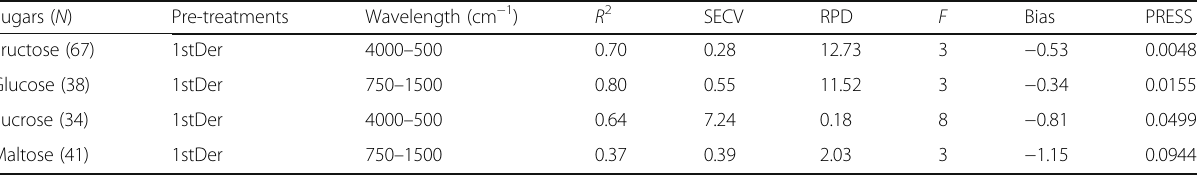
Table 2 Calibration and cross-validation statistics for sugars on freeze-dried mango samples Sugars ( N )